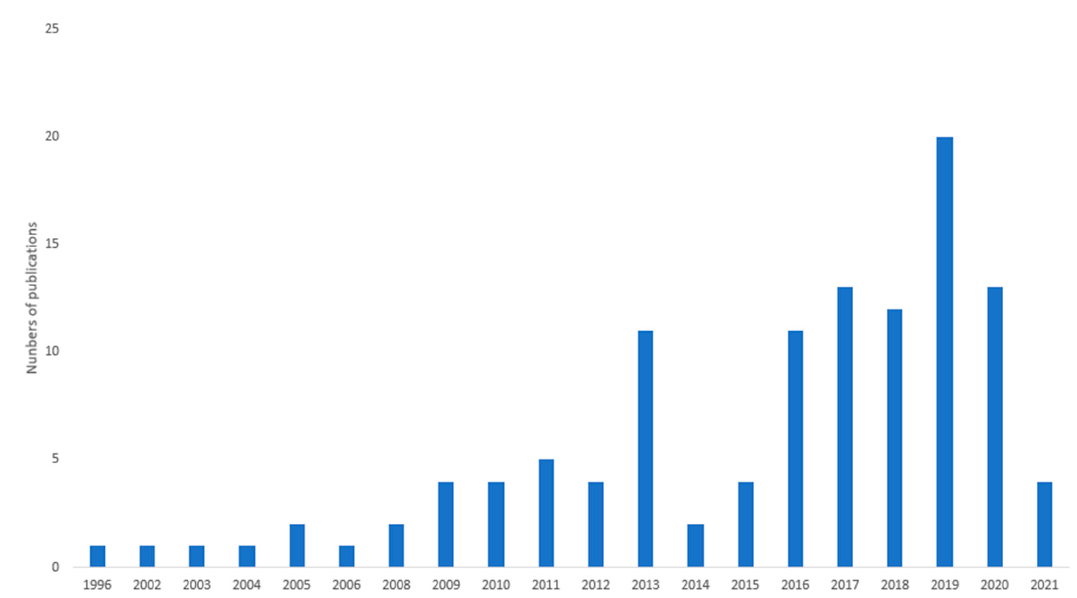
Figure 2. Distribution by publication year of the 116 publications included in the analysis.